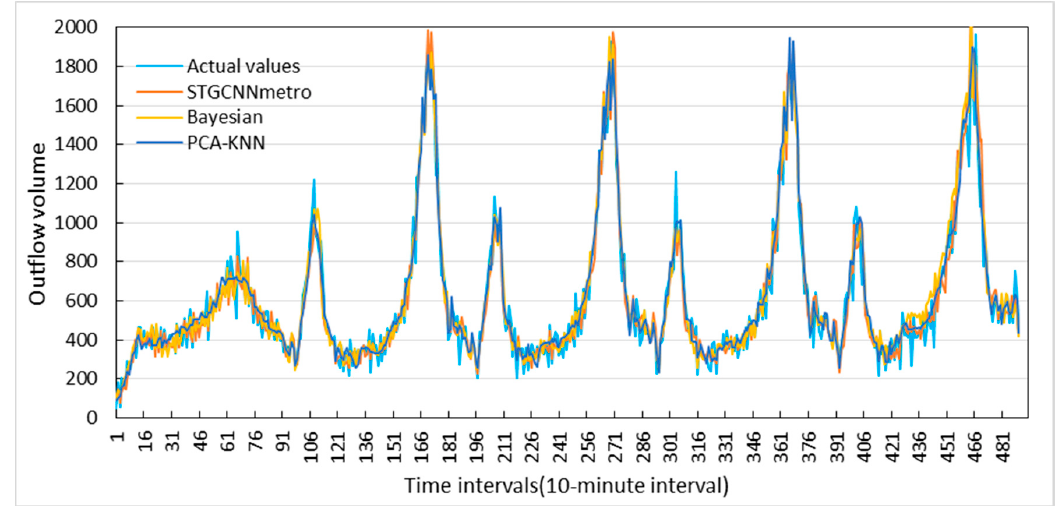
Figure 9. A comparison of the predicted and actual values of passenger outflow volume per 10 min using the test data from the Shenzhuang metro station. Data cover five consecutive days (from Sunday to Thursday).